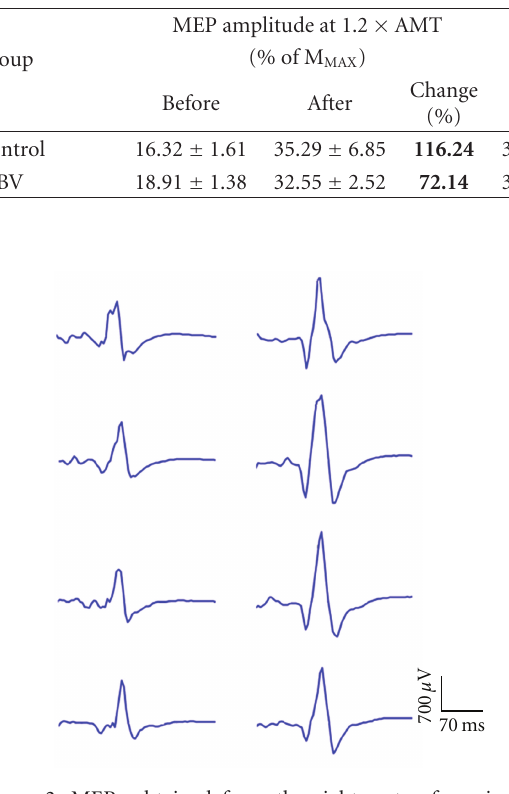
Figure 2: MEPs obtained from the right rectus femoris of one participant in the WBV group obtained at 1.2 × AMT. The four sweeps on the left show preintervention MEPs, and the four sweeps on the right show facilitated MEPs following 4 wks of training. These results were similar for both